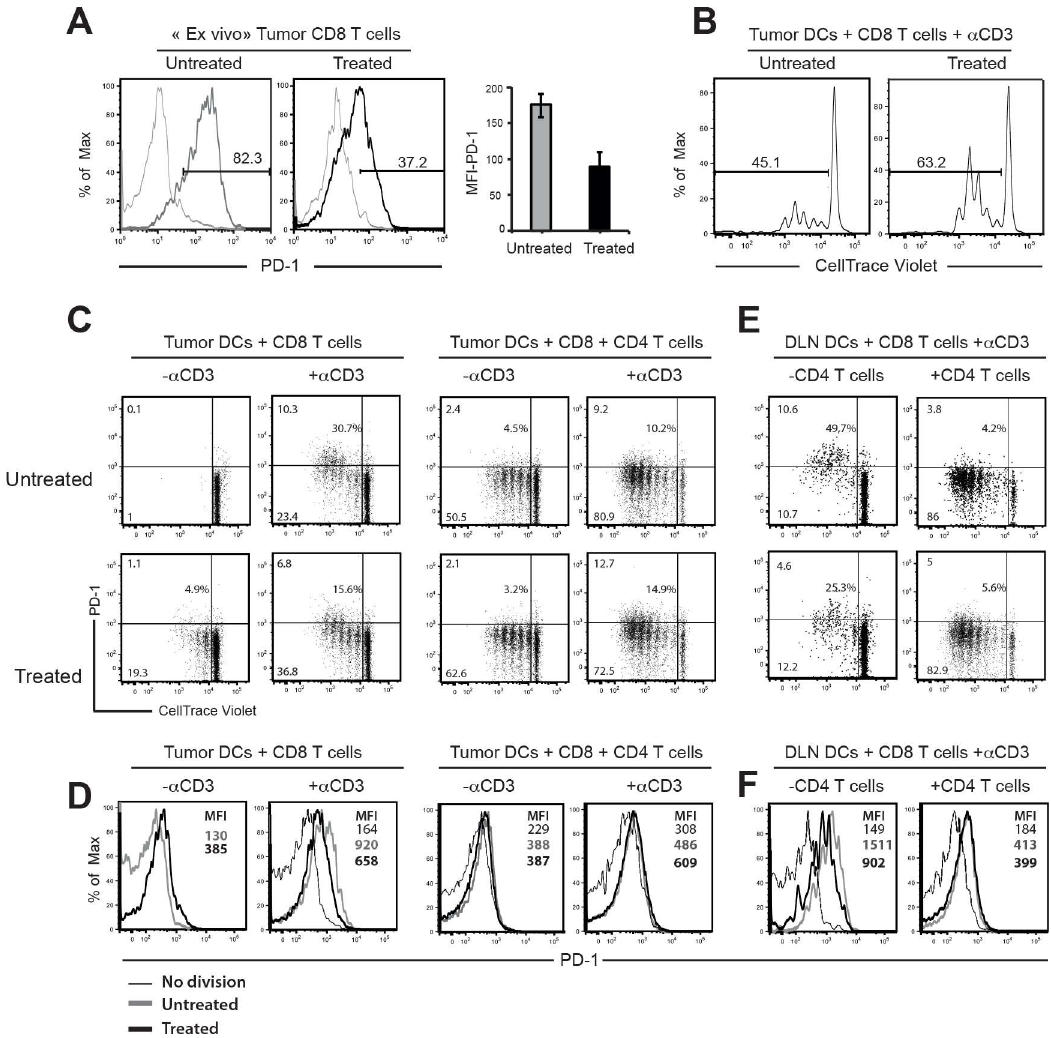
Fig 5. DCs from PC61-depleted mice and CD4 T cells reduce the percentages of CD8 T cells expressing high level of PD-1. (A) Histograms show cell surface expression of PD-1 on infiltratingCD8 T cells from treated and untreated tumours resected at day 14 (Left) and mean Fluorescence Intensity (MFI) of PD-1 in each group (Right). (B) CD11c hi MHC II hi tumour DCs were sorted from treated and untreated mice and cultured 3 days with na ï veCD8 T cells labelledwith CellTraceviolet and 0.1 μ g/mlof anti-CD3mAb. (C,D) Flow cytometry analysingthe expressionof PD-1 on dividingcells. CD11c hi MHC II hi DCs from Tumours (C) and CD11c hi DCs from DLNs (D) were purifiedfrom untreated and PC61-treated mice and co-cultured 3 days with CellTraceviolet-labelled CD8 T cells and in the presenceor not with anti-CD3mAb or CD4 T cells. Percentagesof cells expressingPD-1 are represented in the middle of the graphs. (E,F) Histograms represent the level of PD-1 expressiongated on all dividingcells accordingto indicatedcultures. Results represent two